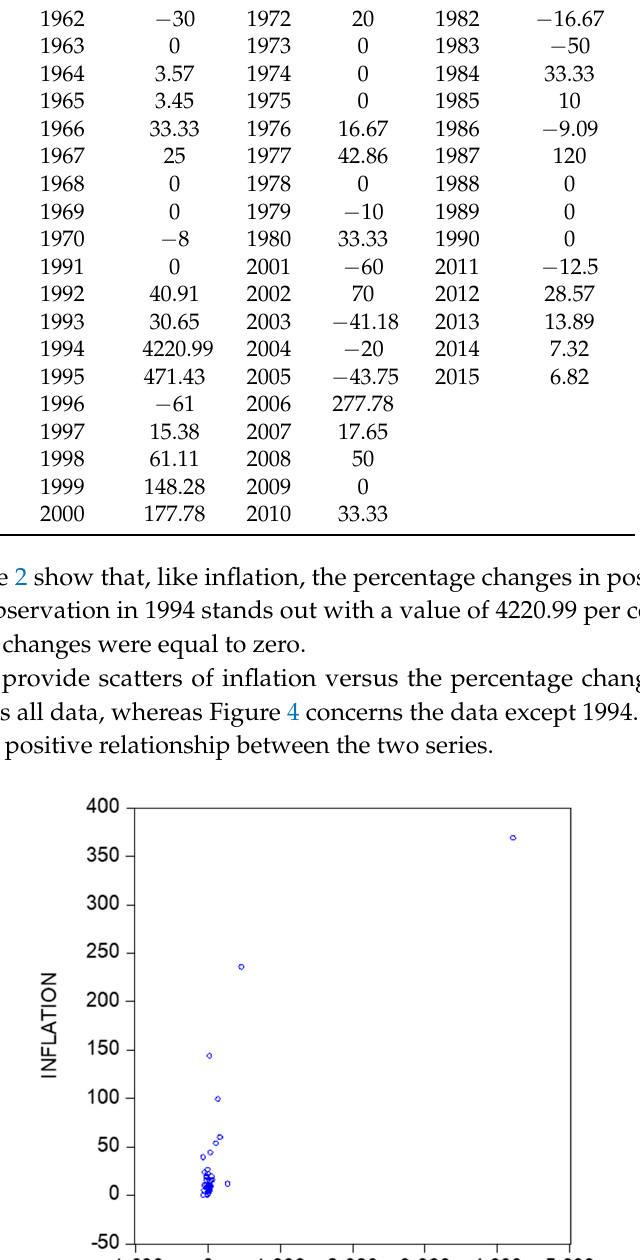
Figure 4. Scatter of inflation versus percentage changes in stamps prices (excluding 1994). 3. Two Econometric Models In this section, we consider two econometric models to link inflation with changes in stamp prices. We denote annual inflation as (cid:1851) (cid:3021) and the annual changes in stamps prices as (cid:1850) (cid:3021) . For inflation, we have only annual data, but for the stamps prices, we can also construct quarterly data. Each year,